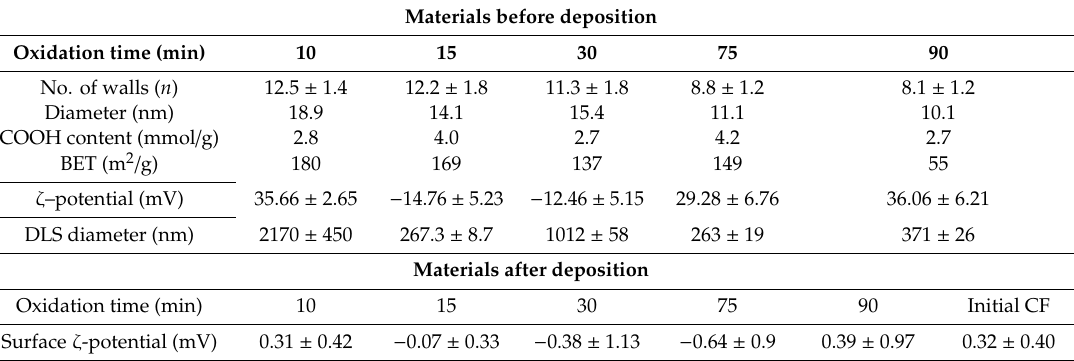
Table 1. Characteristics of carbon nanotubes (CNTs) before and after the electrophoretic deposition (EPD) process. CF: carbon